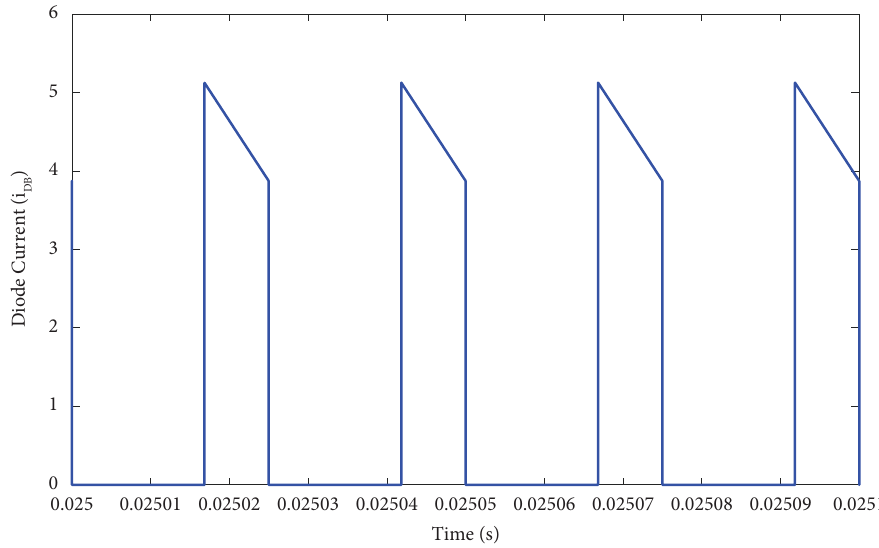
Figure 16: Te diode D B simulated current waveform.